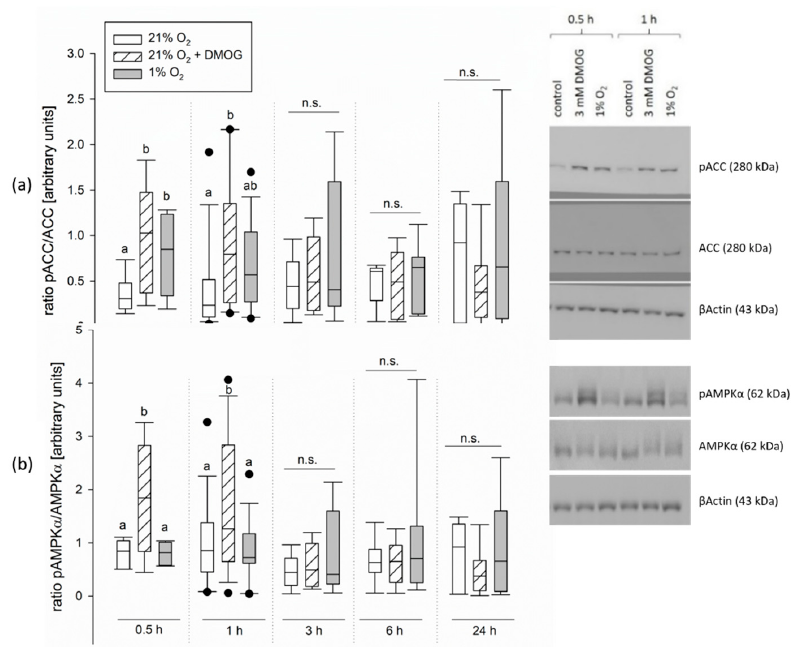
Figure 4. Activation of AMP-activated protein kinase (AMPK) in CaCo-2 cells as indicated by the phosphorylation of AMPK α and its target ACC. Cells were incubated under 21% O 2 (white bars), with 3 mM DMOG (hatched bars) or kept at 1% O 2 (grey bars) for 0.5, 1, 3, 6, or 24 h, as indicated at the x-axis. Total protein was extracted, separated by SDS-PAGE and AMPK α , ACC, pAMPK α , and pACC were detected using Western blot. ( a ) The ratio of pACC/ACC was increased after 0.5 h in both treatment groups and after 1 h of incubation with DMOG. Longer incubation times did not increase pACC compared to the control group incubated at 21% O 2 . ( b ) The ratio pAMPK α /AMPK α was increased after incubation with DMOG for 0.5 and 1 h as well. However, there was no significant increase after hypoxic incubation compared to the control group incubated at 21% O 2 . Longer incubation times had no effect. Boxes show the median, 10th, 25th, 75th, and 90th percentile plus error bars. Outliers are represented by dots. One-way repeated measurements ANOVA, p < 0.01, N = 4 ( n = 8) for 6 h, N = 3 ( n = 6) for 24 and 3 h, N = 5 ( n = 10) for 1 and 0.5 h. Right side: representative blots after 0.5 and 1 h incubation time.